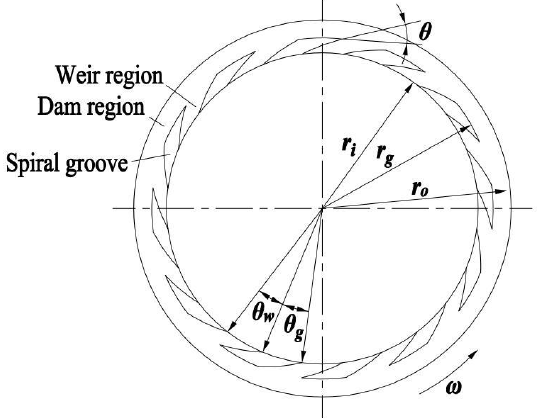
Figure 1. End-face structure of the spiral groove figure.